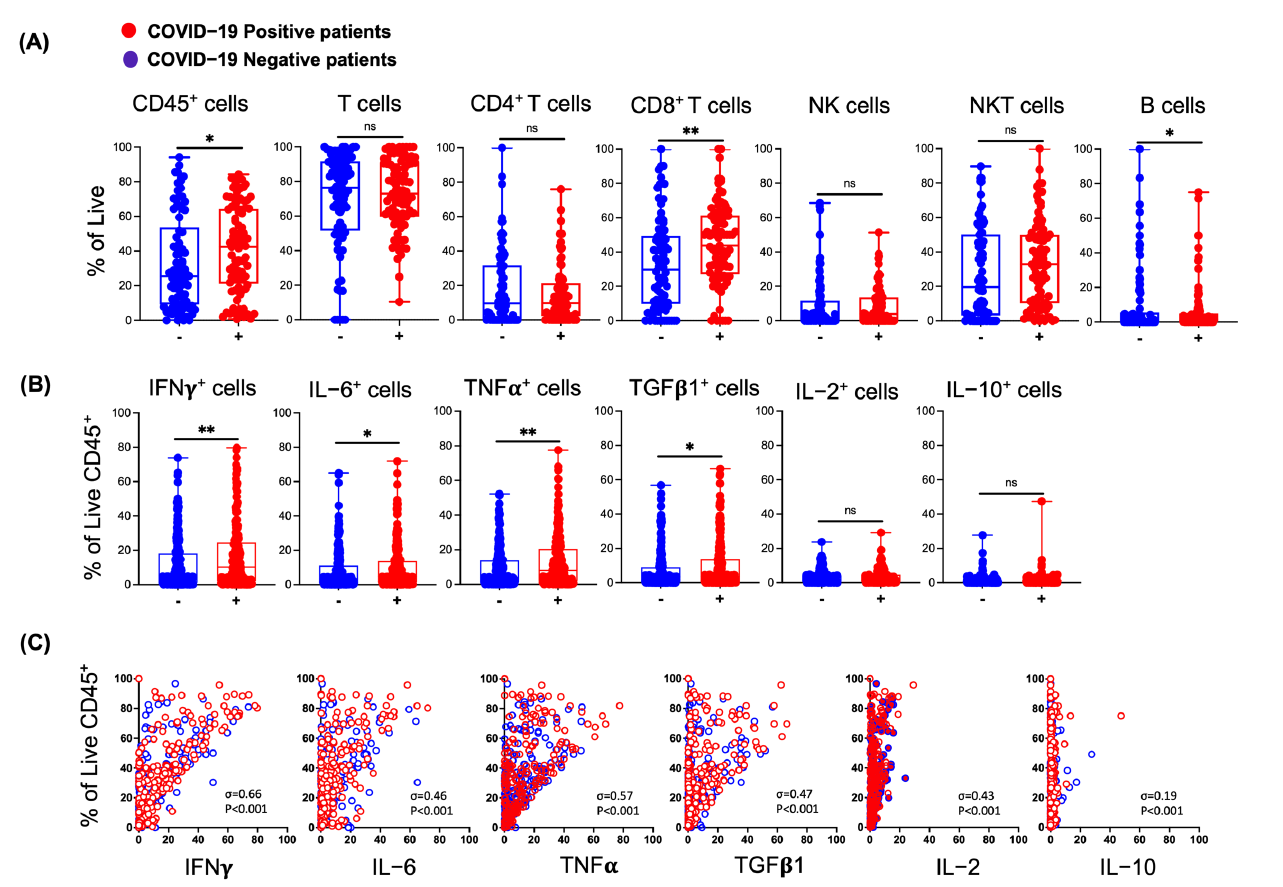
Figure 3. SARS-CoV-2 infection affects major immune subsets belonging to the nasopharynx-associated lymphoid tissue (NALT) and potential links to lymphocyte-driven cytokines. ( A ) Frequencies of major immune subsets in nasal swabs of RT-PCR COVID-19-positive (N = 64) and -negative (N = 74) patients. ( B ) Intracellular cytokine expression by the nasopharyngeal lymphocytes (CD45 + ) in nasal swabs of COVID-19-positive (N = 140) and -negative (N = 148) patients. ( C ) Spearman correlations of nasopharyn- geal lymphocytes (CD45 + ) with various intracellular cytokines between COVID-19-positive (N = 140) versus -negative (N = 148) patients. Each dot represents an individual. * denotes p ≤ 0.05, ** denotes p ≤